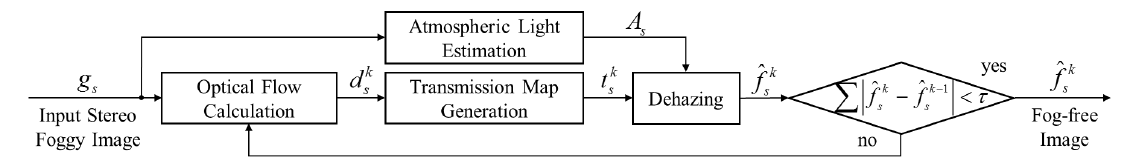
Figure 2. Block diagram of the proposed defogging algorithm: For s ∈ { L , R } , g s is the input stereo image pair, A s is the global atmospheric light, d k s , t k s , and ˆ f k s , respectively, are the disparity map, the transmission map, and the defogged image at the k -th